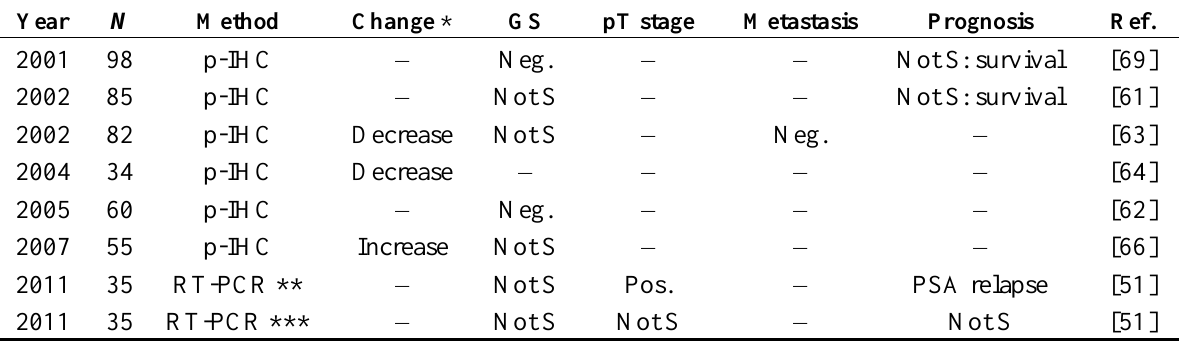
Table 1. Correlation between TSP-1 expression and clinicopathological features in prostate